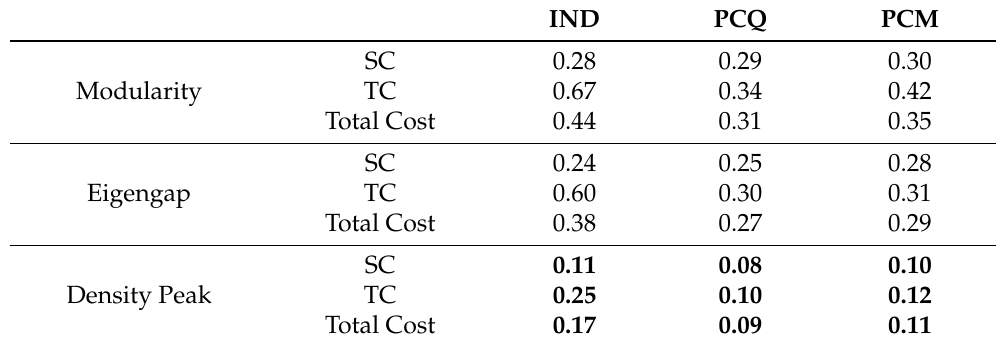
Figure 14. Histogram of link speeds for the time period = 6 in the case of the eigengap. Table 2. Performance under the density peak, the modularity and the eigengap